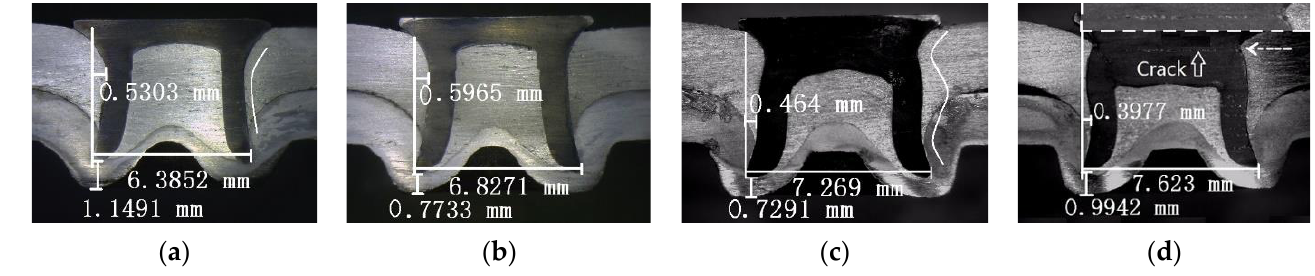
Figure 4. Cross ‐ sectional profiles of an SPR joint.